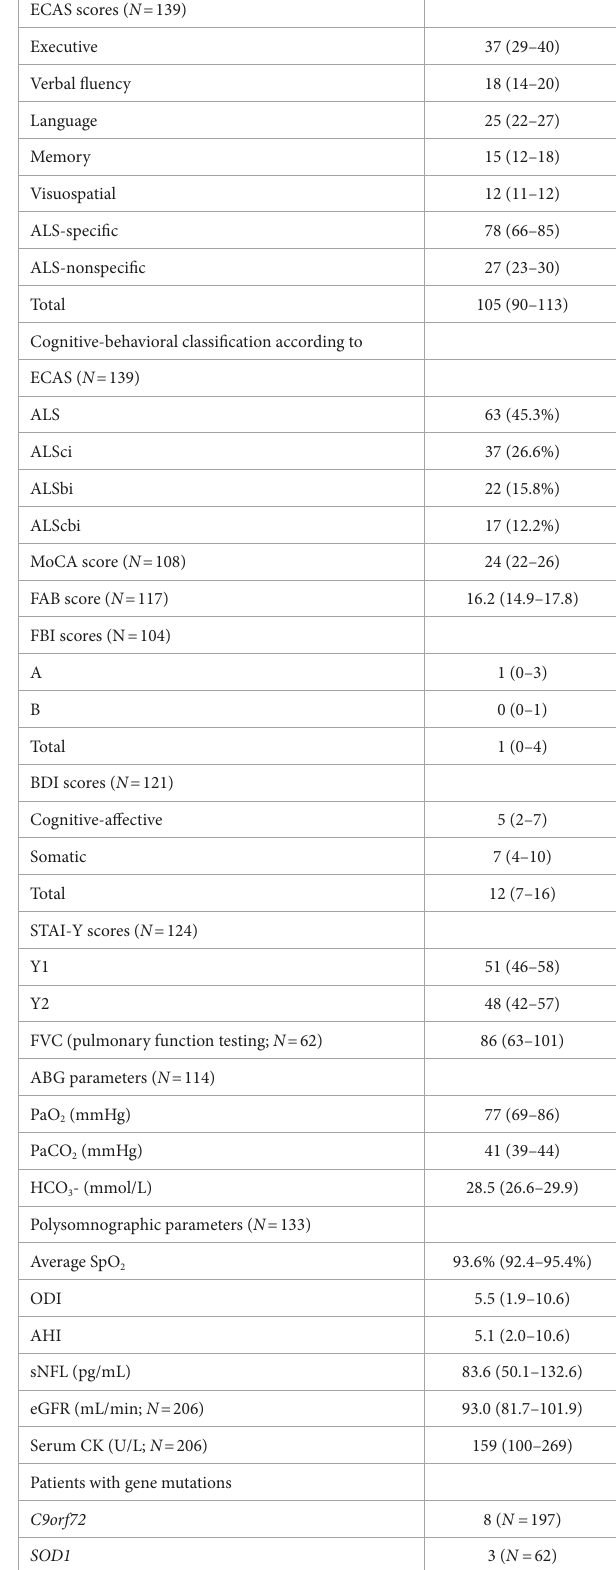
TABLE 1 Demographic and clinical features of ALS patients and results of instrumental and laboratory